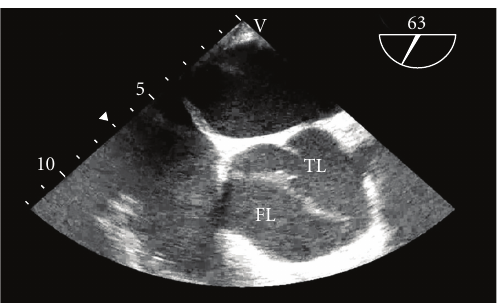
Figure 1: TEE image of the proximal ascending aorta (approxi- mately at level of sinotubular junction) in mid-esophageal short axis view. The true lumen (TL) can be seen with the right, left, and noncoronary cusps. The false lumen (FL) is clearly obvious and occupies approximately forty percent of the aortic luminal area. This pathology caused severe aortic insu ffi ciency which was demon- strable with color flow doppler (not shown).